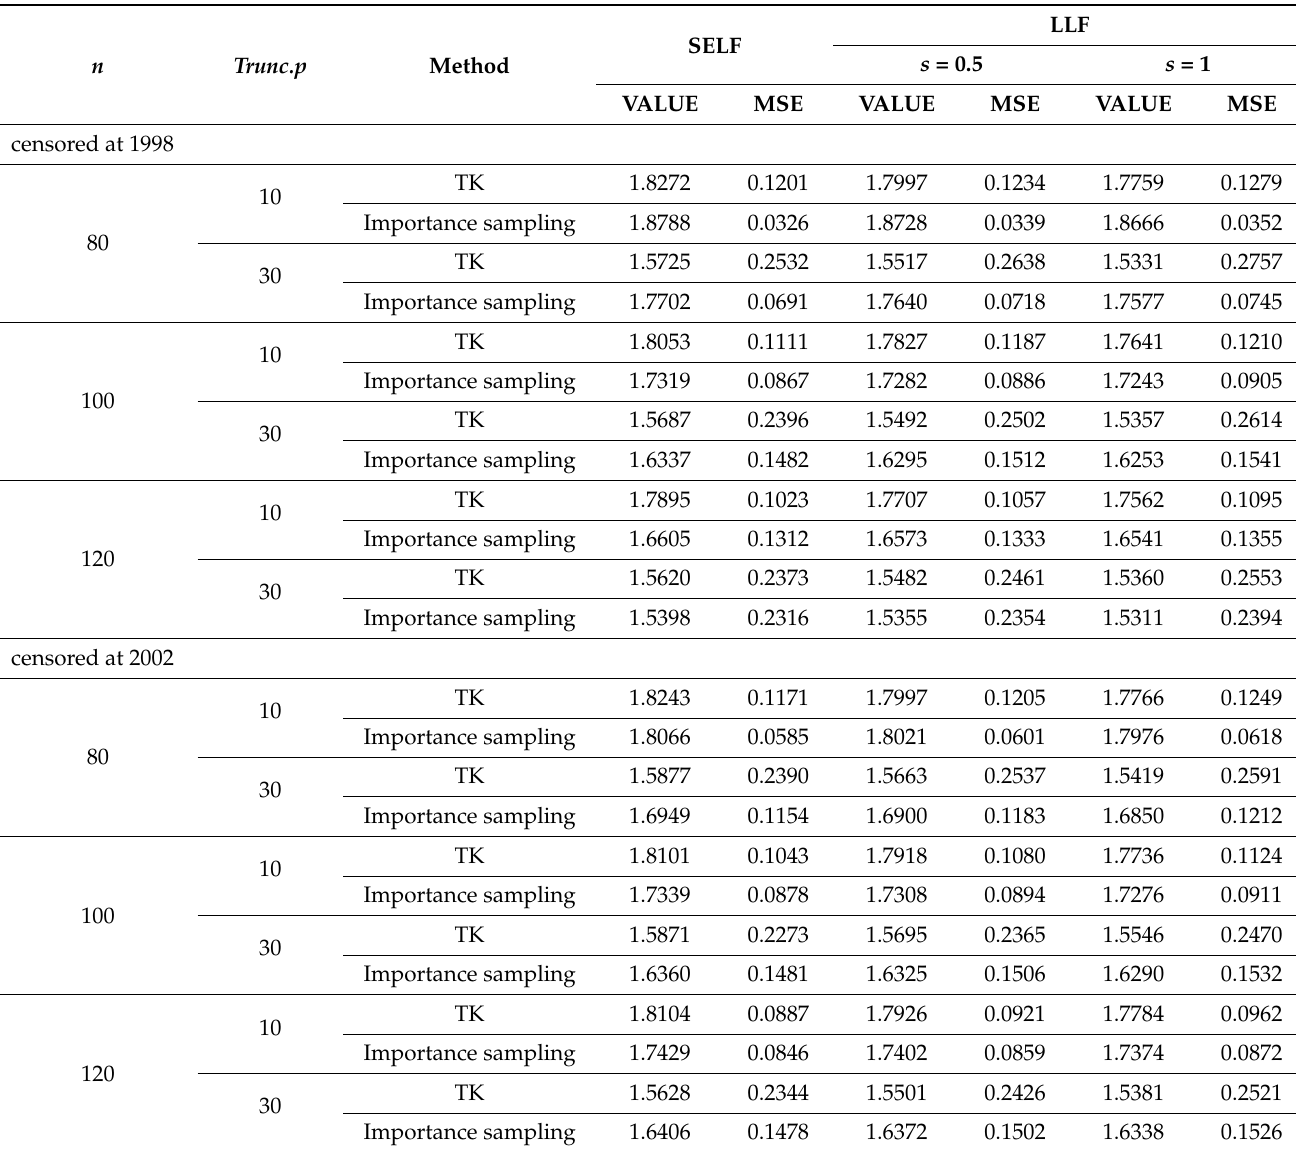
Table A4. The results of informative Bayesian estimates for λ using TK approximation and impor- tance